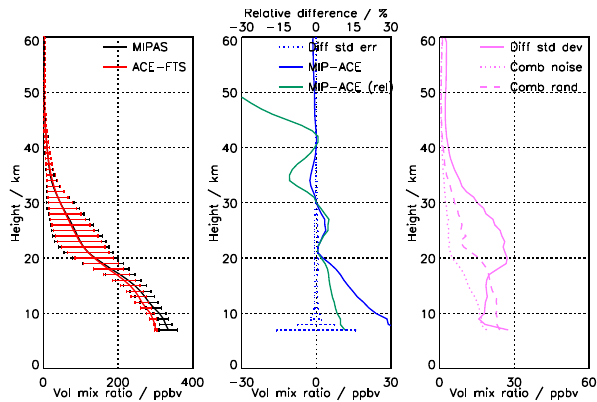
Figure 17. Comparison of N 2 O from ACE-FTS and MIPAS re- duced resolution (V5R_N2O_224 and V5R_N2O_225) in 60– 90 ◦ N in February and March. Details as in Fig.